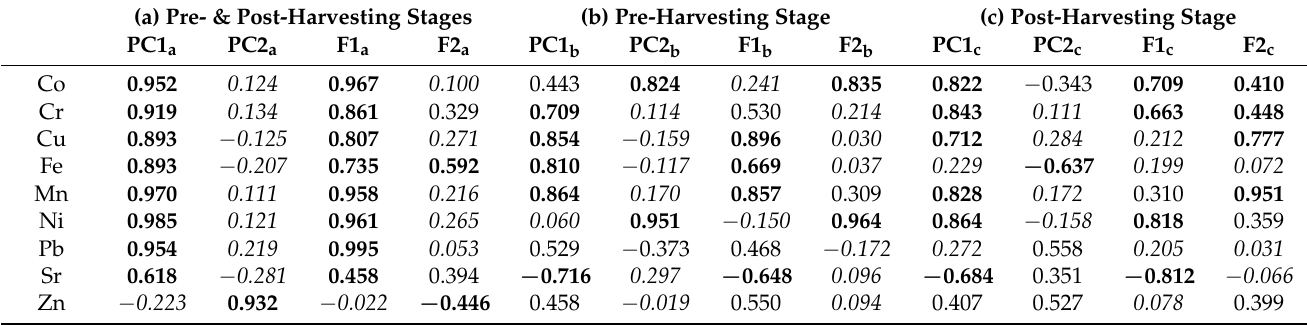
Table 8. PCA initial loading matrix and rotated factor loadings matrix 2